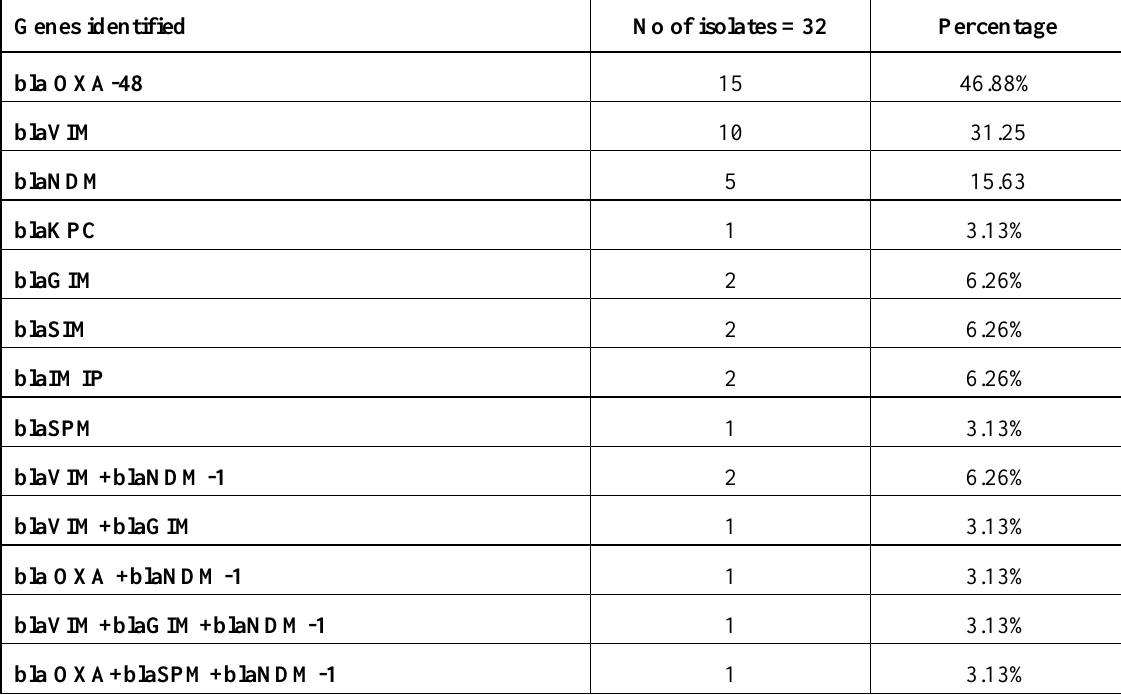
Table 3. Carbapenem-resistant genes distribution in P.aeroginosa strains among studied groups Genes identified